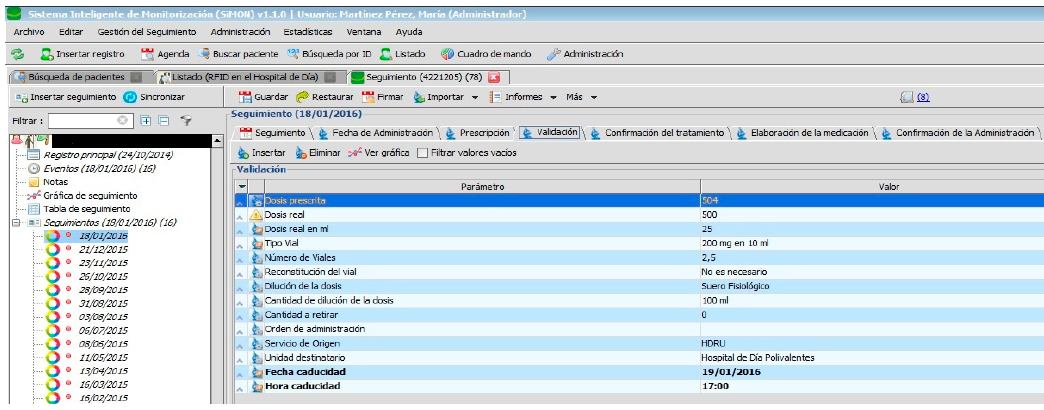
Figure 6. Validation of medication.